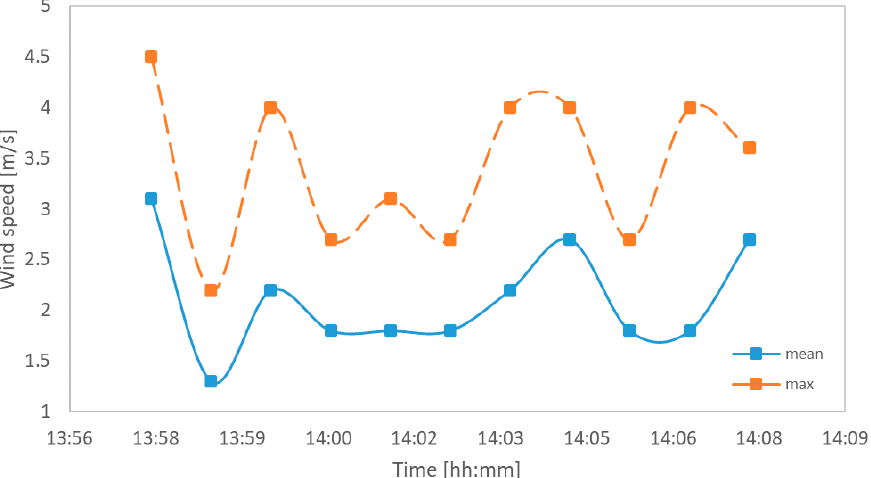
Figure 14. Wind speed at the height of 1.5 m for the selected timeframe, maximum value for 1-min intervals (orange), average value for 1-min intervals.